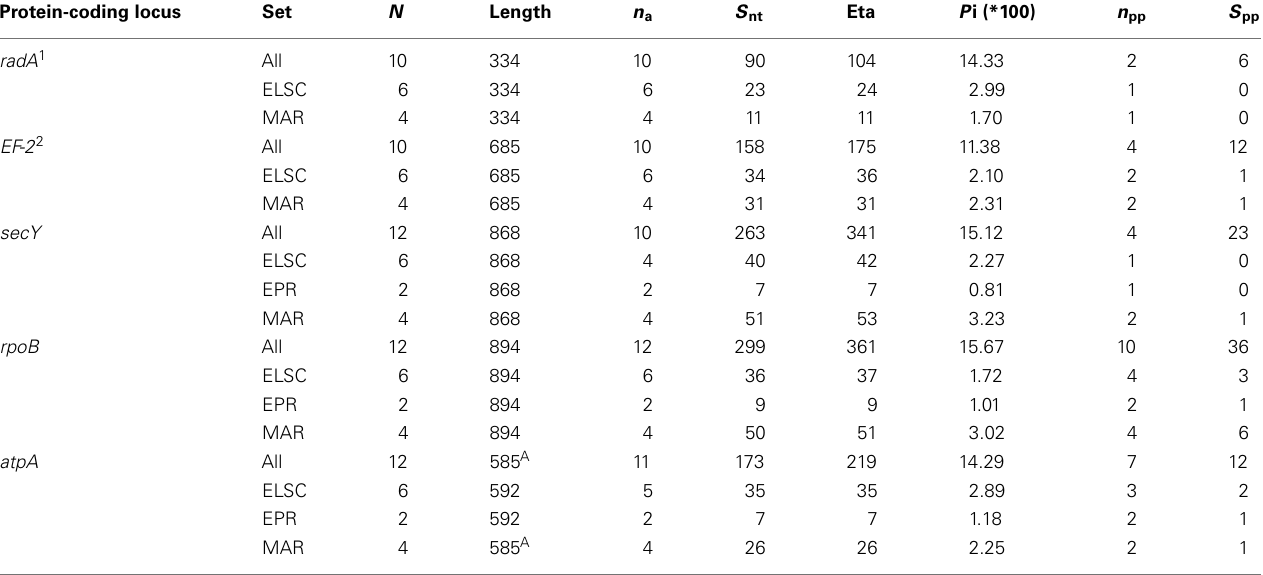
Table 4 | DNA polymorphism and nucleotide sequence characteristics of the five protein-coding loci examined from the DHVE2 isolates. Protein-coding locus Set